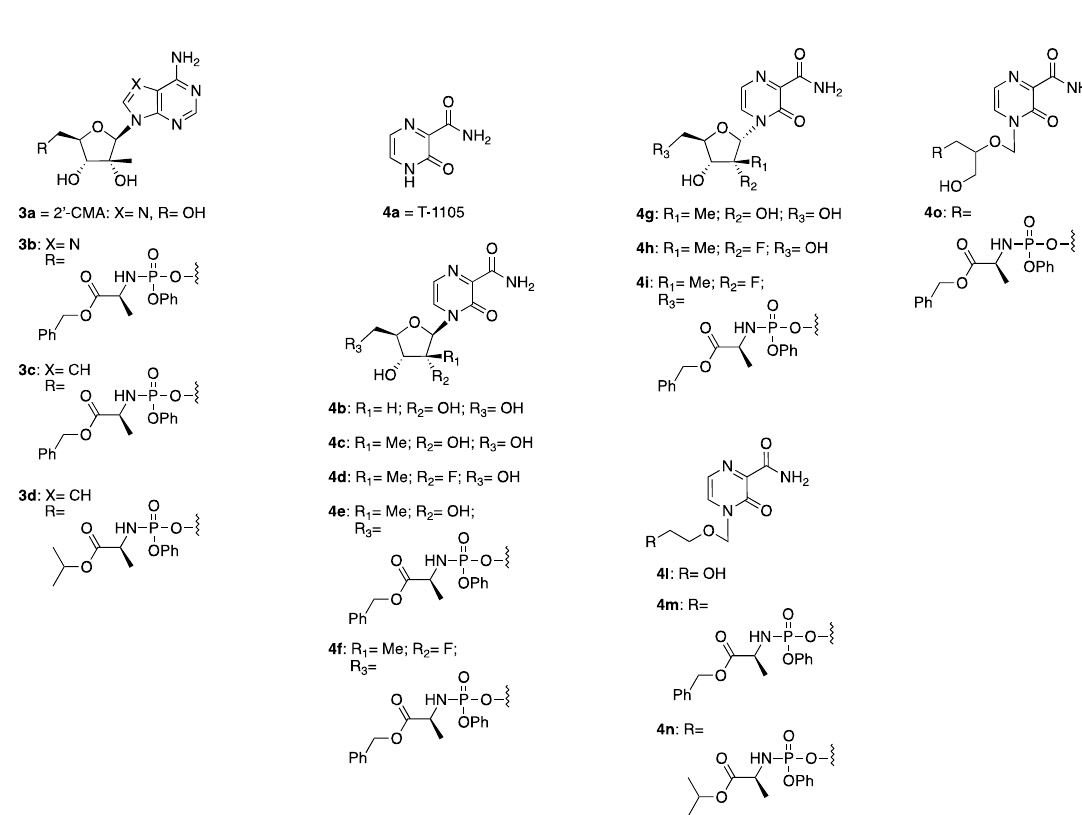
Figure 1. Chemical structures of nucleoside analogues 3a – 3d and 4a – 4o . The parent compounds 3a and 4a have been previously found to inhibit ZIKV replication in cell-based assays.